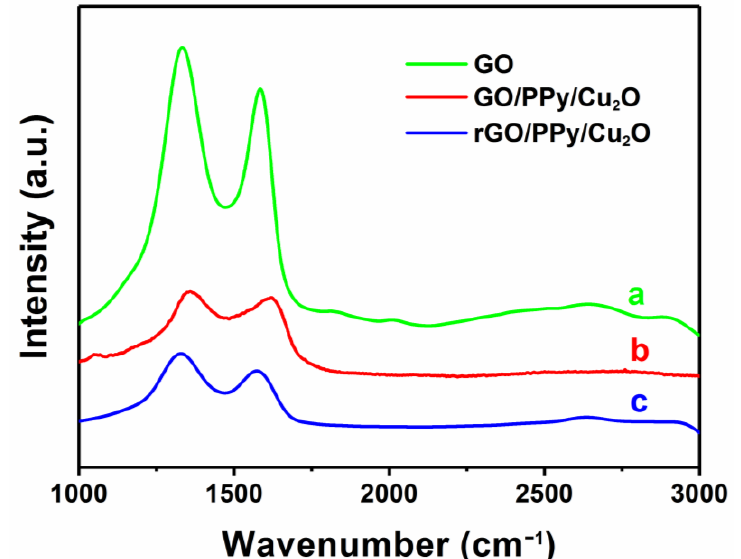
Figure 6. Raman spectra of (a) GO, (b) GO/PPy/Cu 2 O and (c) rGO/PPy/Cu 2 O.